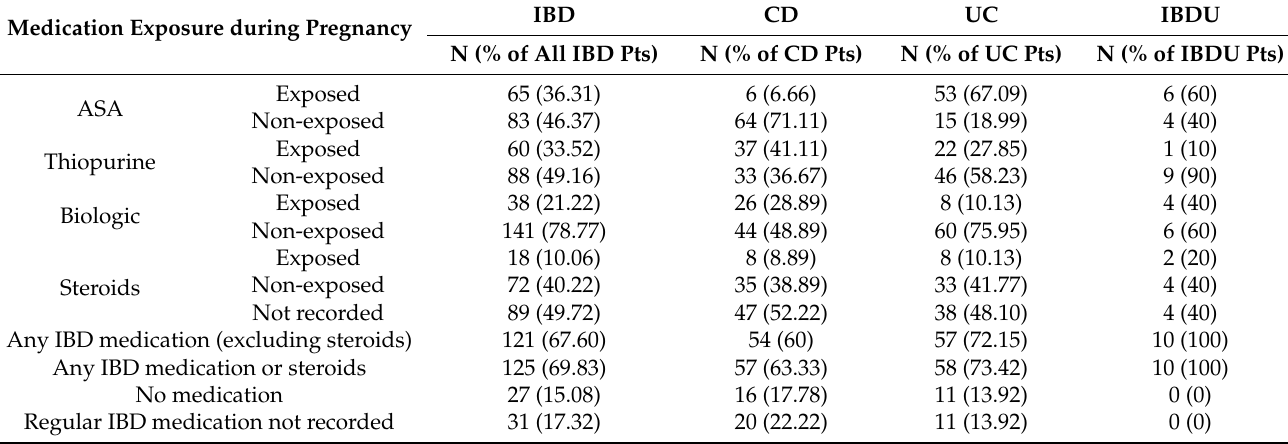
Table 2. Medication exposure (“Exposed” patients had been prescribed either IBD medication or steroids during pregnancy. “Unexposed” patients were either naïve to the specific medication, or had not been prescribed it within at least three months prior to pregnancy. Table percentages reflect the proportion of total study IBD population (N = 179) and IBD subtypes (CD N = 90; UC N = 79; IBDU N = 10). Missing data are reflected where totals do not add up to N.